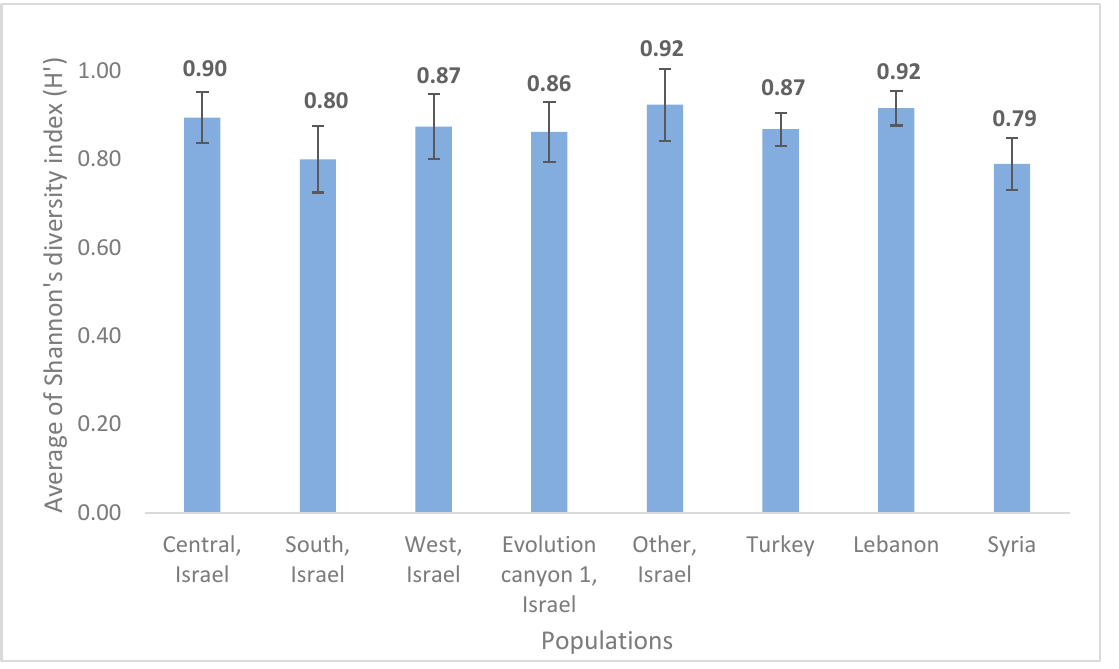
Figure 4. Graphical representation on average of Shannon’s phenotypic diversity index (H’) for different populations. Error bar denotes mean ± SD.